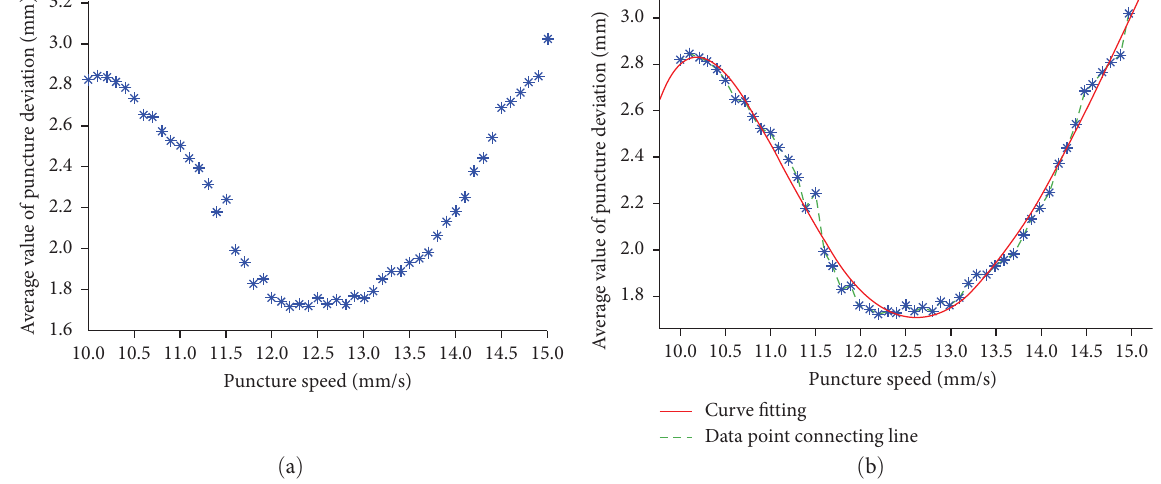
F IGURE 8: Results of optimization experiments: (a) distribution map of experimental results; (b) curve fi